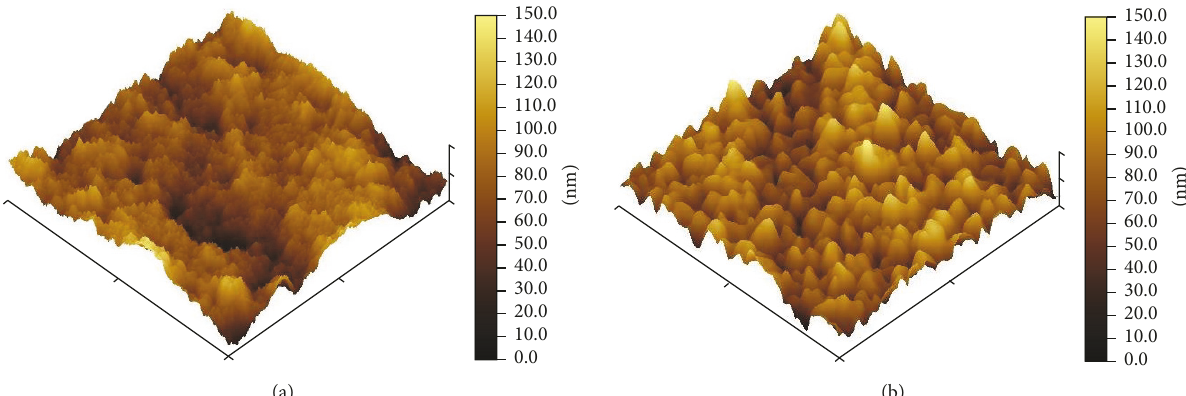
Figure 7: AFM images of (a) electrodeposited Ag, 𝑅 𝑎 = 13.8 nm, 𝑆 𝑑𝑟 = 2.49%; (b) physical vapour deposited Ag, 𝑅 𝑎 = 14.5nm, 𝑆 𝑑𝑟 =